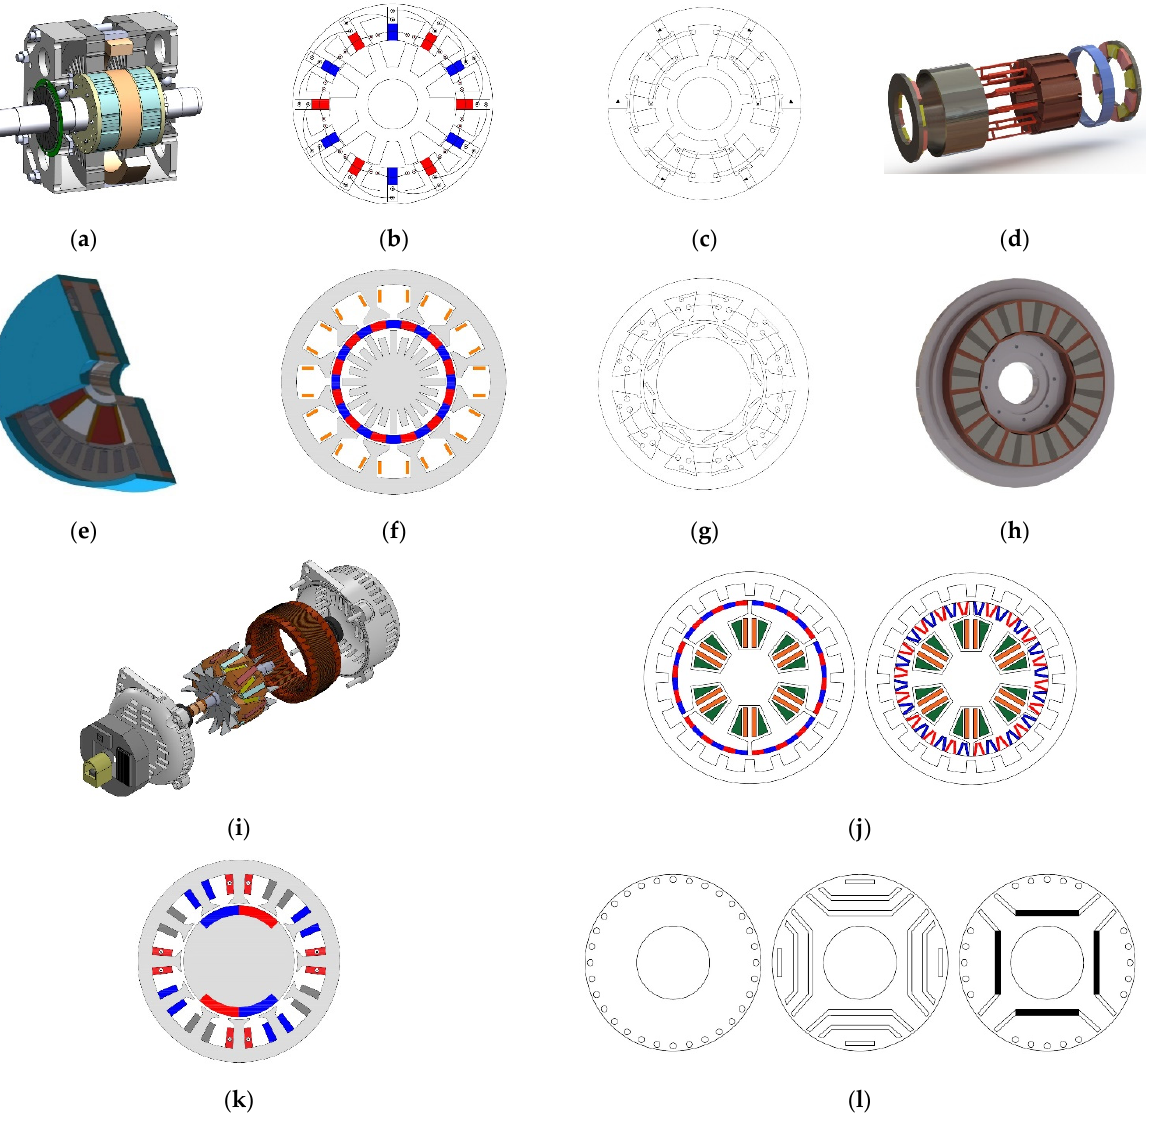
Figure 1. ( a ) Hybrid-excited synchronous machine with contactless energy transfer [1]; ( b ) hybrid- excited switched-flux permanent magnet machine [3]; ( c ) doubly salient machine [7]; ( d ) axial flux hybrid excitation motor [9]; ( e ) axial-radial flux machine [12]; ( f ) dual rotor/stator machine [14]; ( g ) Hybrid-Excited Machines with DC winding on stator [15]; ( h ) stator of double stator inner rotor axial air gap flux switching permanent magnet machine [16]; ( i ) hybrid-excited claw pole genera- tor [17]; ( j ) hybrid-excited Vernier machine [18]; ( k ) consequent-pole permanent magnet machines [19]; ( l ) rotor of induction motor, line-start synchronous reluctance motor, and line-start interior permanent magnet synchronous motor